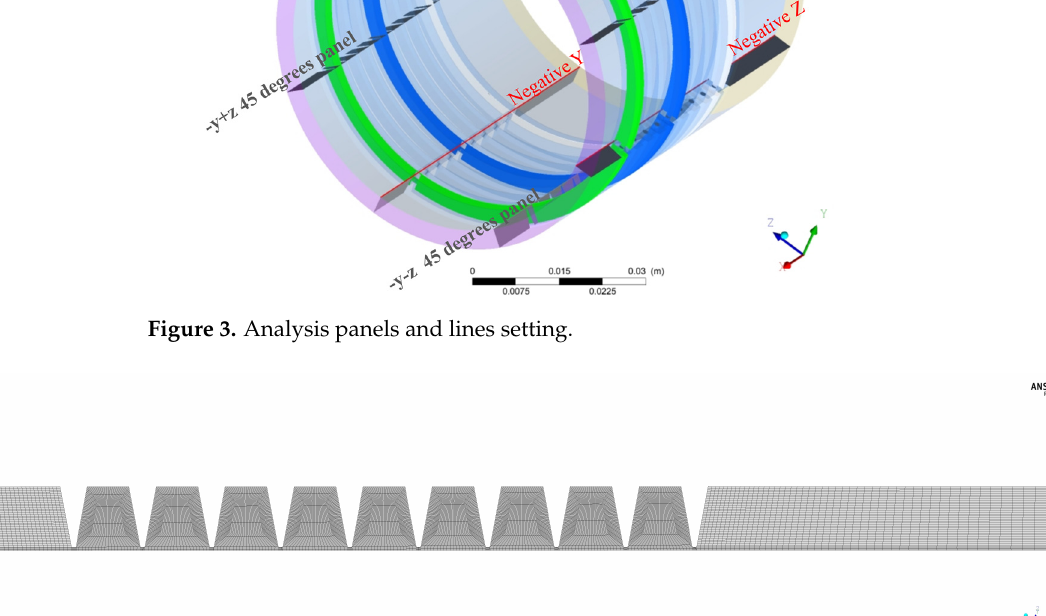
Figure 3. Analysis panels and lines setting.